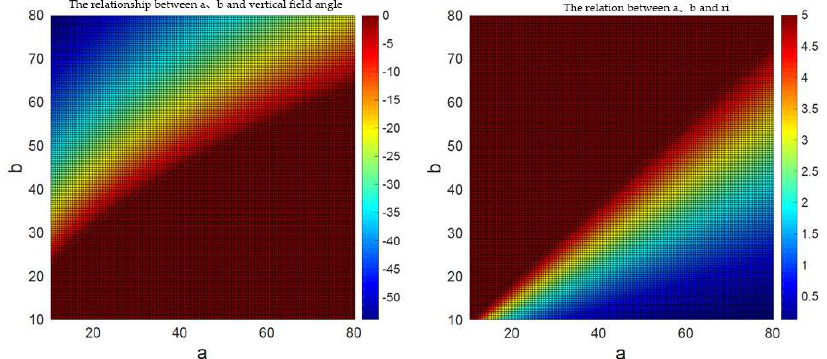
Figure 4. Feasible solutions of a, b and vertical field of view angle with constraints (left) and feasible solutions of a, b and ri with constraints (right).